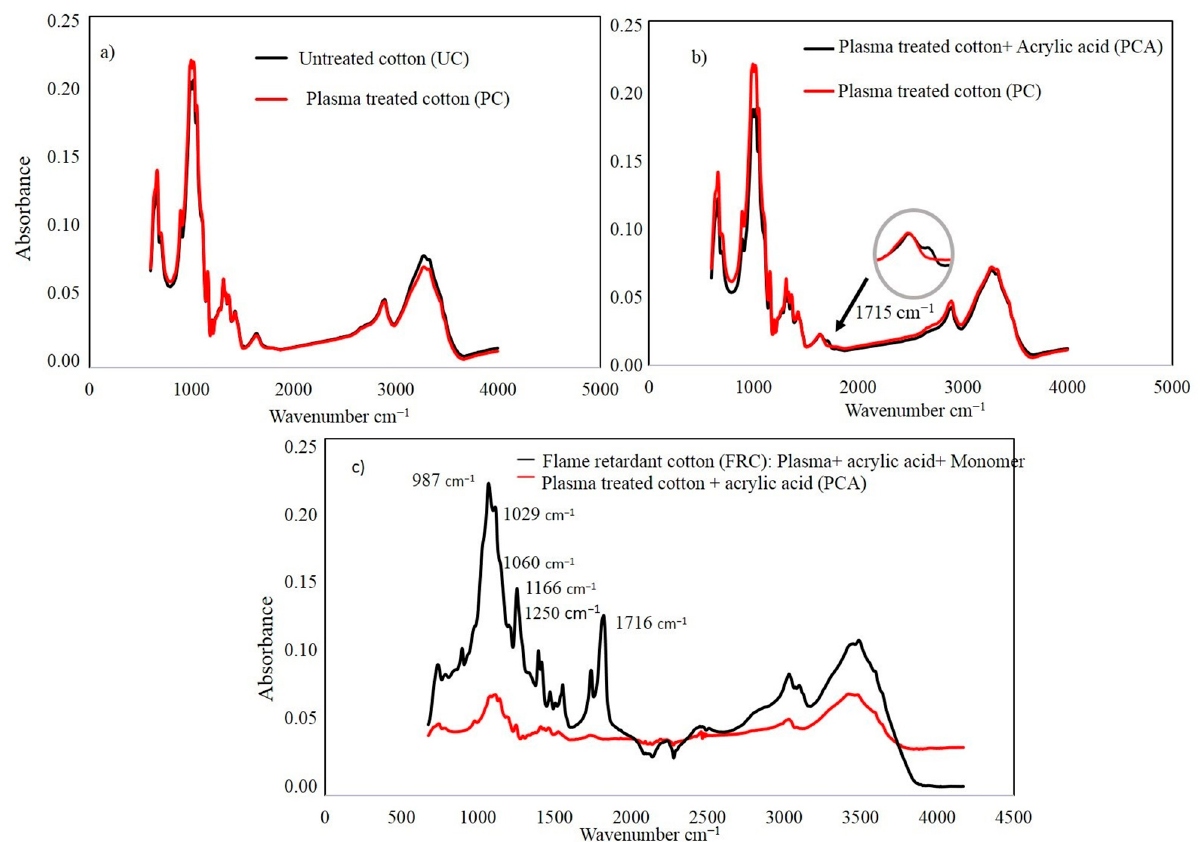
Figure 4. Attenuated total reflectance Fourier-transform infrared (ATR-FTIR) spectra of untreated and plasma-treated cotton ( a ) before grafting with acrylic acid, ( b ) after grafting with acrylic acid and ( c ) after monomer immobilization.